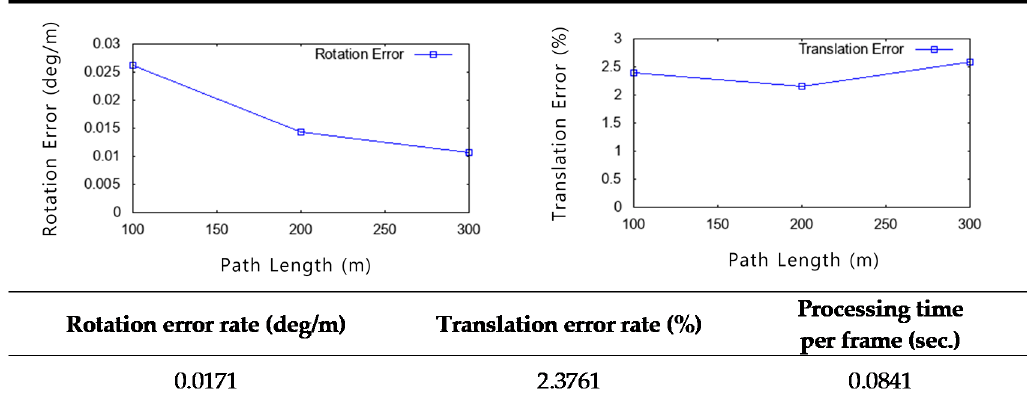
Figure 17. Graph of error over mileage for sequence 03.